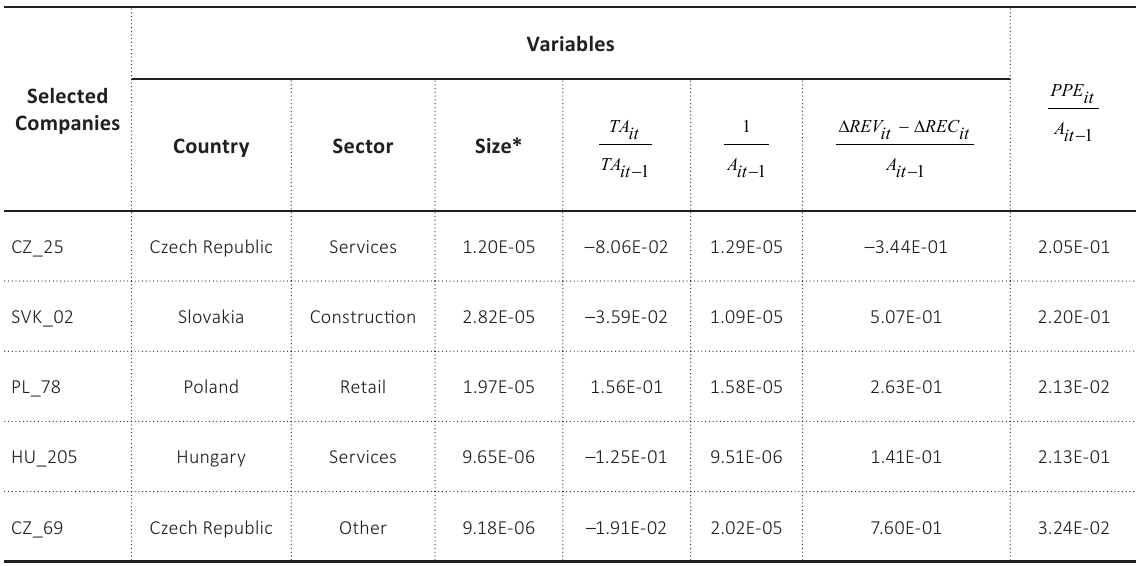
Table 3. Results of the variables calculation for five selected